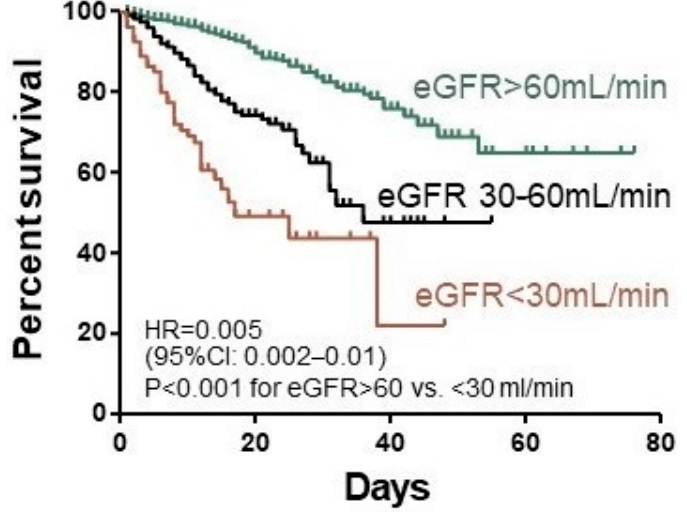
The independent predictors of 28-day mortality in logistic regression analyses were age, baseline SpO2, the ordinal scale of 4 and 5, neutrophil and platelet count, eGFR, and CRP concentration (Figure 1, Table 7).